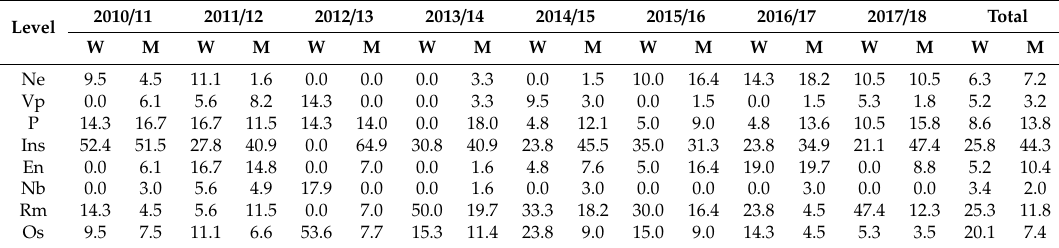
Table 2. Level of achievement of cartwheel, according to academic years, temporary totality and gender. Level